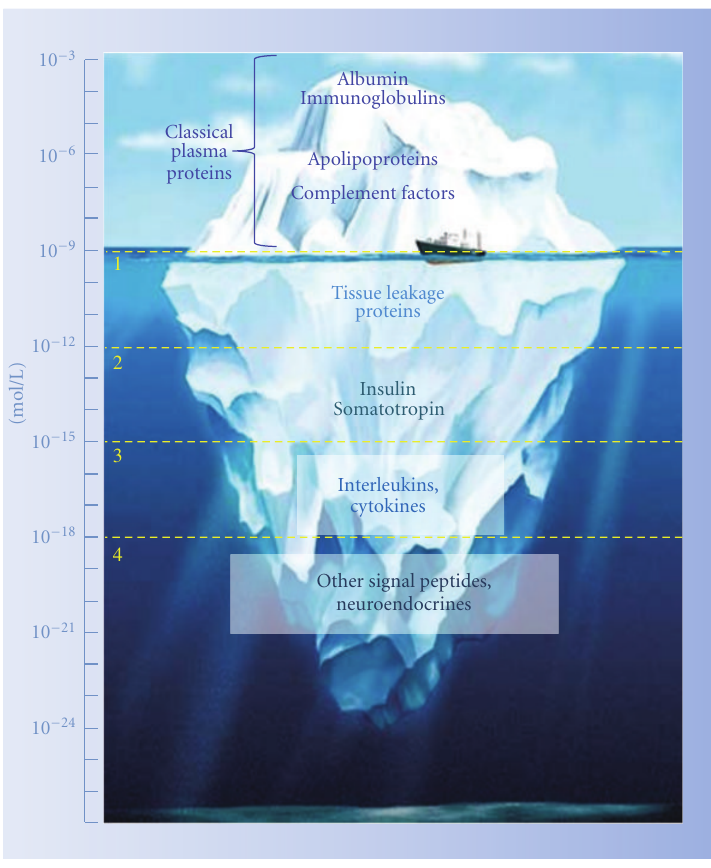
Figure 1: Illustrative iceberg representation of high dynamic range of proteins found in blood, showing various classes of proteins and peptides (figure composed of literature data [21] and others). Four arbitrary assemblies of proteins/peptides can be made, and representative species are indicated. Iceberg tip contains abundant classical plasma proteins detectable in 1 μ L of sample or less. Tissue leakage proteins typically require, at least, 1mL plasma volumes (typically after depletion of interfering abundant proteins), and concentration ranges of secreted signal peptides/proteins like insulin, somatotropin are yet another 3 orders of magnitude lower. Interleukins and other cytokines really push current MS systems to their very limit, whereas other neurosecretory signal peptides require extensive concentration steps to reach levels detectable by MS.